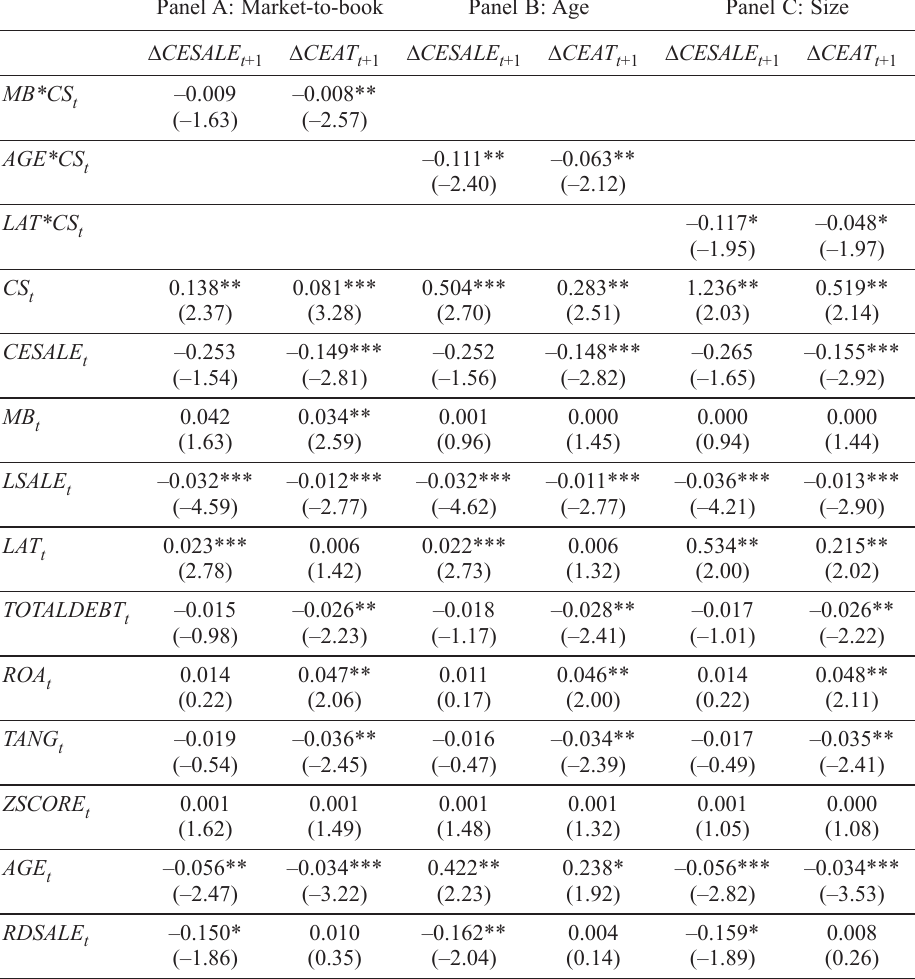
Table 4. Customer satisfaction, firm characteristics and capital expenditures Panel A: